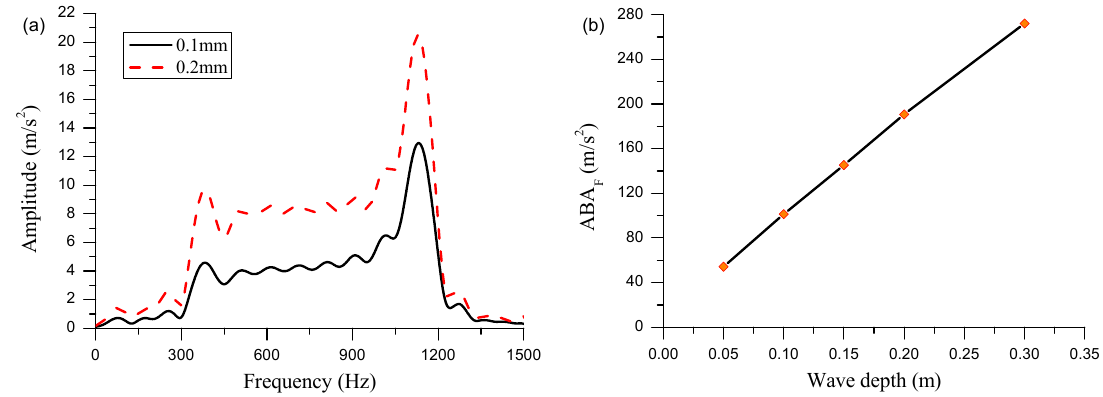
Figure 12. The influence of wave depth on ABA in ( a ) frequency and ( b ) time domains.